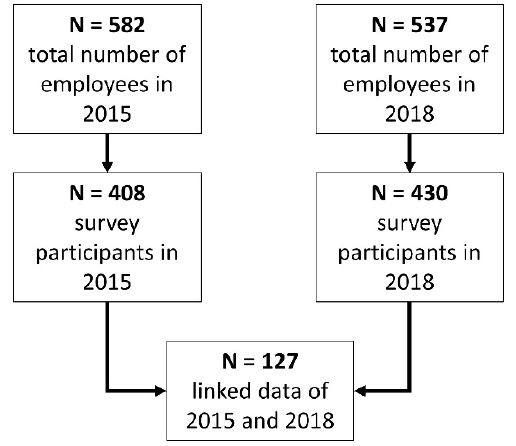
Figure 2. Flowchart of study sample.